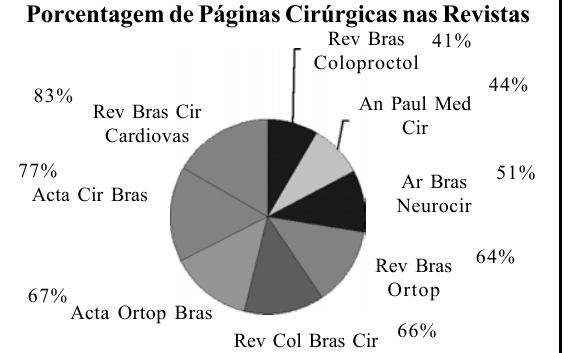
FIGURA 4 (cid:150) Mostra a quantifica(cid:231)ªo das pÆginas cirœrgicas em rela(cid:231)ªo ao total de pÆginas publicadas no triŒnio (1998-2000).